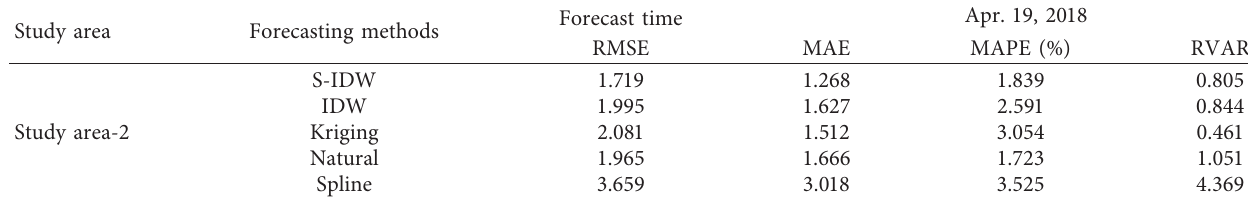
Table 16: Comparison of interpolation accuracy of 5 kinds of interpolation methods on Apr. 19, 2018.